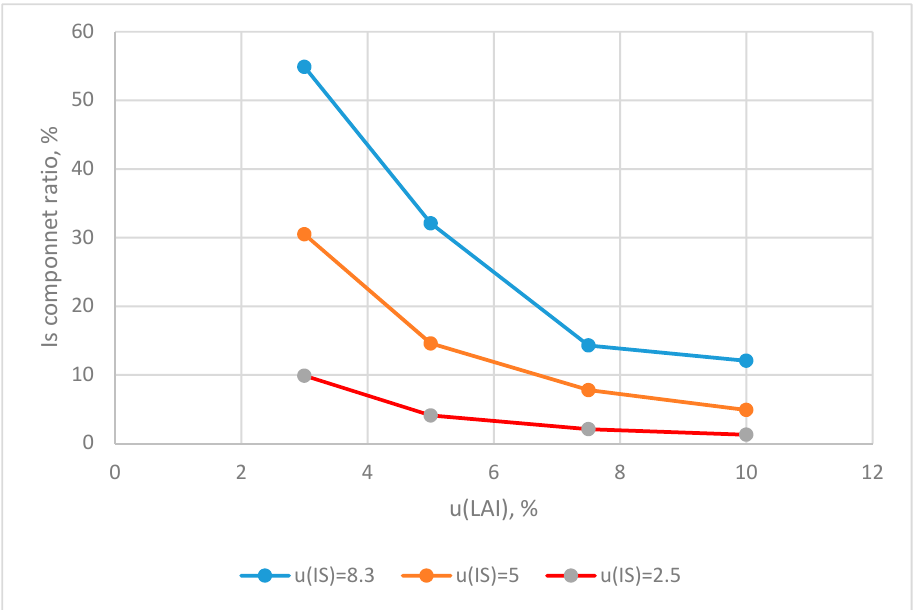
Figure 2. The effect of u(LAI) and u(Is) on the solar radiation (Is) contribution ratio for the Stanghellini equation.